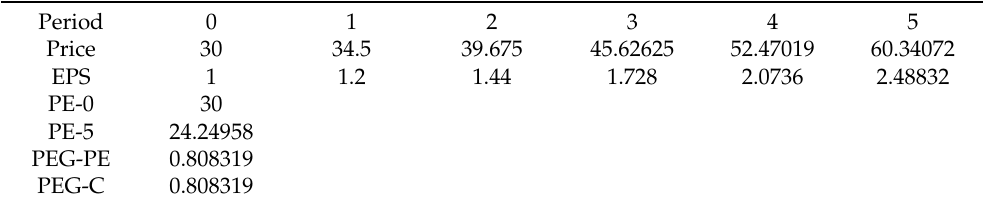
Table 6. The Connection Between the PEG Ratio and P/E